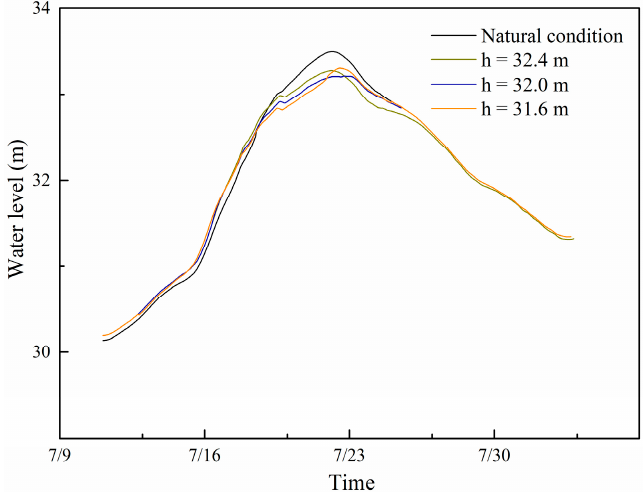
Figure 10. Simulation of fluctuation of water level at Chenglingji station.